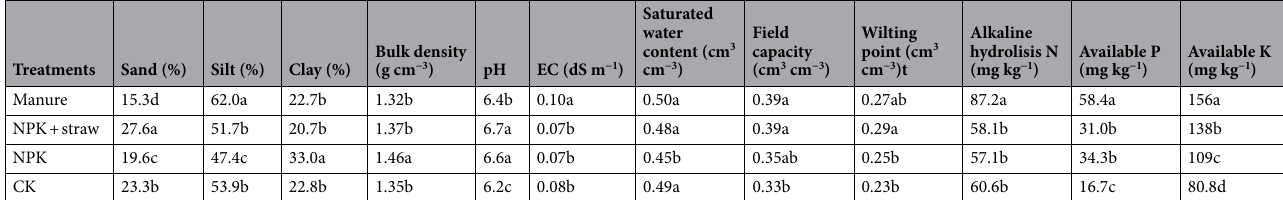
Table 4. The basic soil properties under different long-term fertilization treatments at 0–20 cm. Different lowercase letters indicate the same soil parameter in column was significantly different within